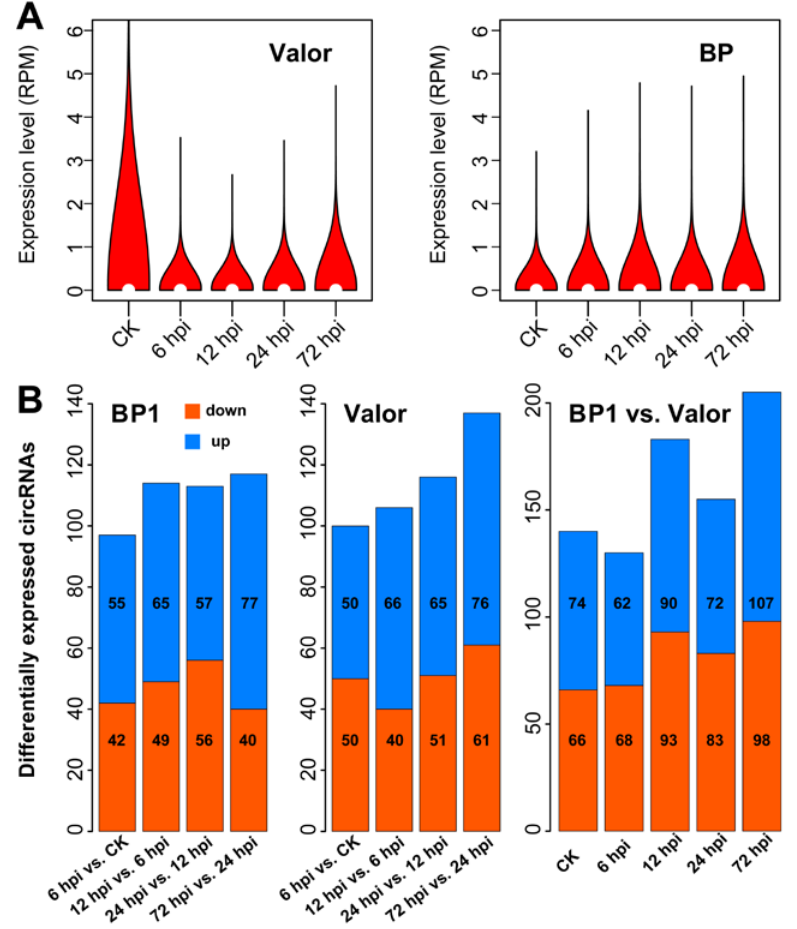
Figure 2. Differentially expressed circRNAs in response to potato- Pectobacterium carotovorum subsp. brasiliense ( Pcb ) infection. ( A ) Violin plot of relative abundance of circRNAs. Data are expressed as the RPM (reads per million mapped reads). ( B ) Number of differentially expressed circRNAs. vs. means versus.